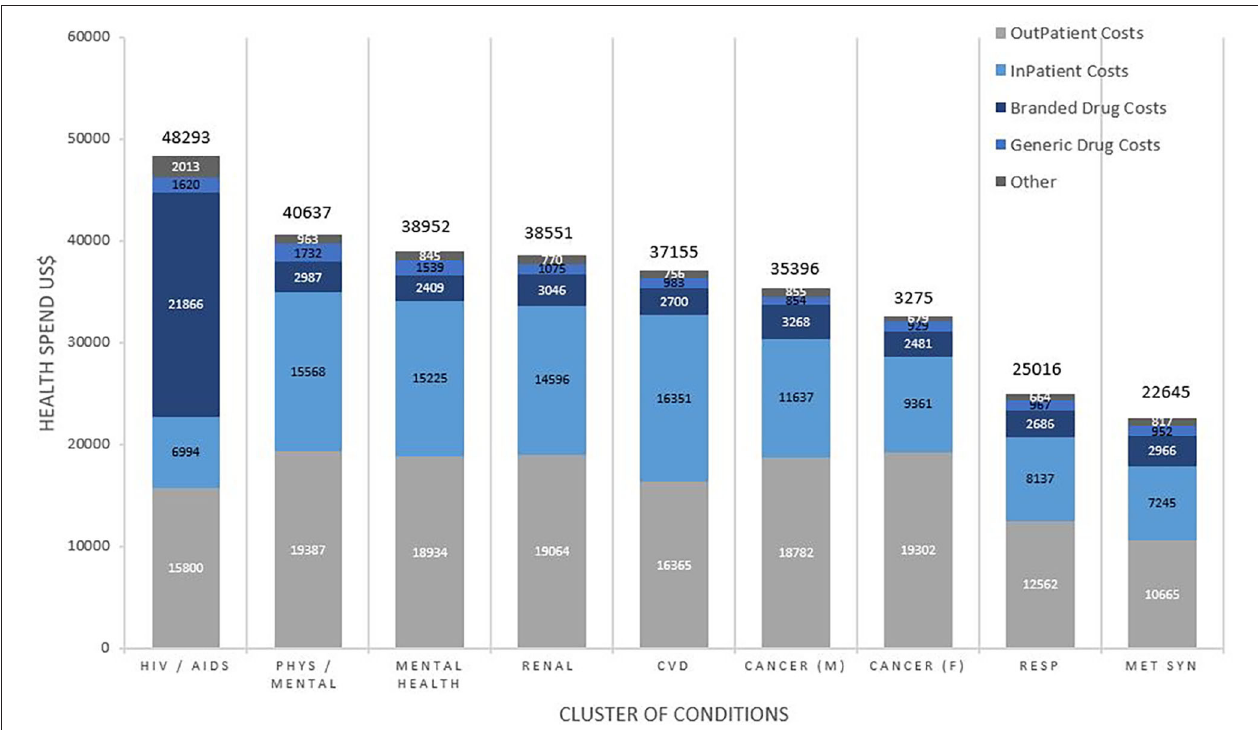
FIGURE 2 | Total average health spend and contributors to cost by cluster of conditions. Costs are weighted to the US population and reported in US$. Comparisons for cost between clusters of conditions were statistically significant overall ( p < 0.001), for inpatient ( p < 0.001), outpatient ( p < 0.001), branded drugs ( p < 0.001), and generic drugs ( p <